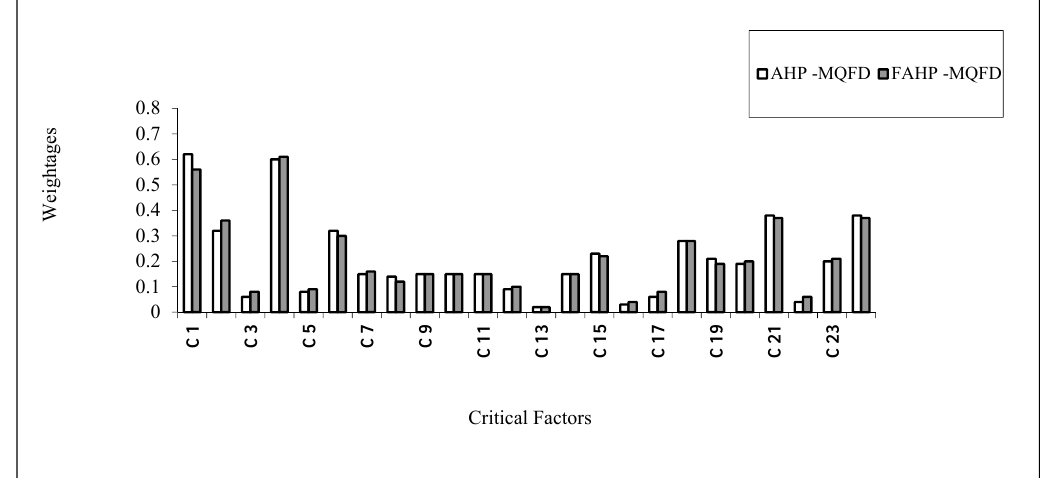
Fig. 3. Difference in local weightages of critical factors